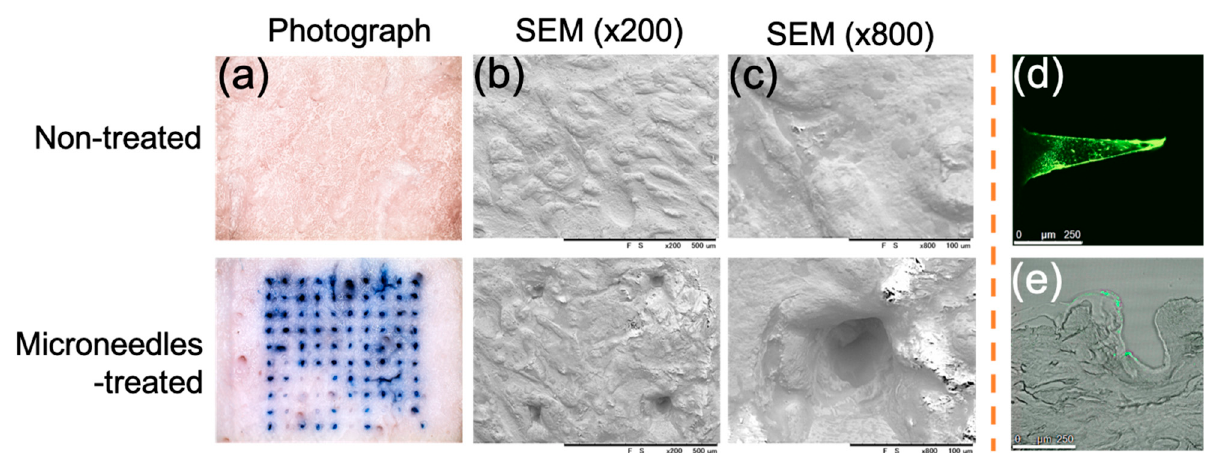
Figure 3. The ability to penetrate the skin in vitro was evaluated by introducing microneedles before and after insertion into the porcine cadaver skin. Skin surface with or without microneedles’ administration was assessed by ( a ) digital color camera; ( b , c ) with different scales by using SEM; ( d ) FITC microneedle section, and ( e ) the histological section using a confocal laser-scanning microscope (scale bar equals 250 μ m).